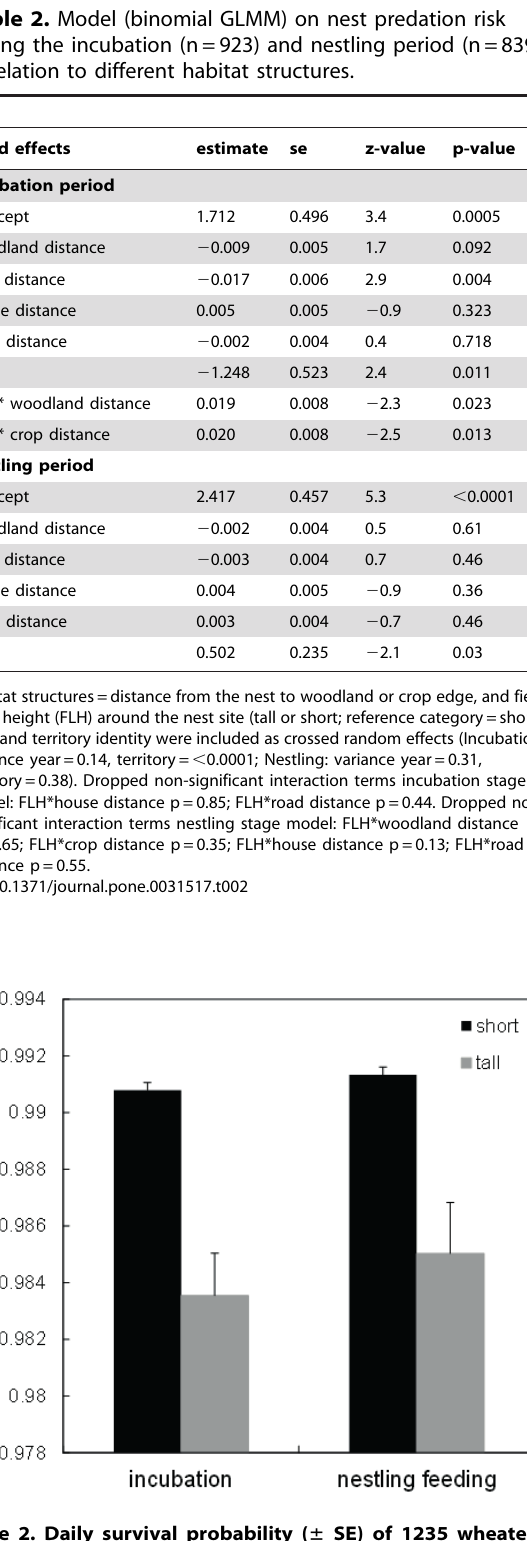
Figure 2. Daily survival probability ( ± SE) of 1235 wheatear nests during the incubation and nestling phase in short field layer (short) vs. tall field layer (tall) habitats. Evidence of predation on nests with an unknown exact location within the territory (N=312 out of 1235) was based on behavioural observations (see methods).